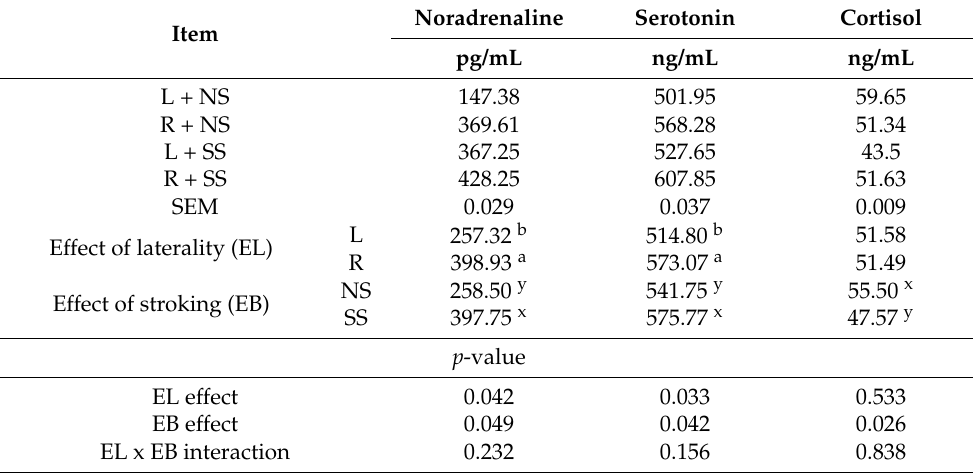
Table 3. Noradrenaline, serotonin, and cortisol levels in the blood serum of dogs in relation to laterality and stroking effects ( n =